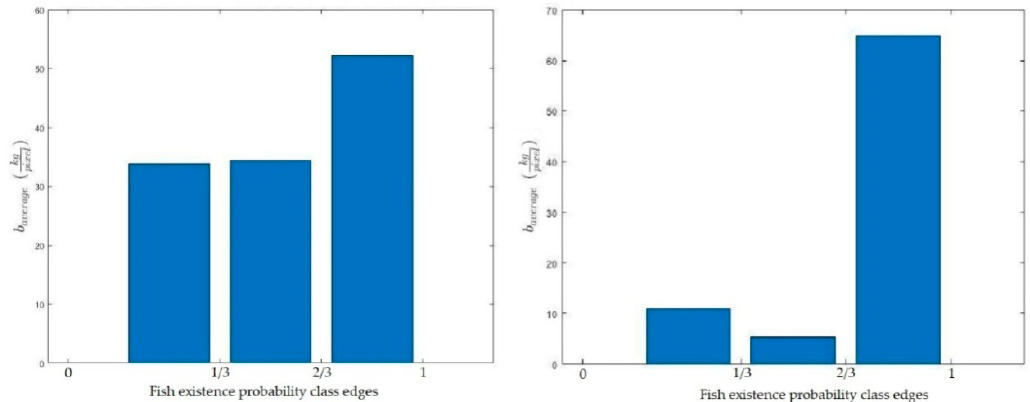
Figure 8. Average biomass density (kg per pixel) per pixel probability class for probability-based pixel classification of Landsat 5 ( left ) and Landsat 8 ( right ) validation image.